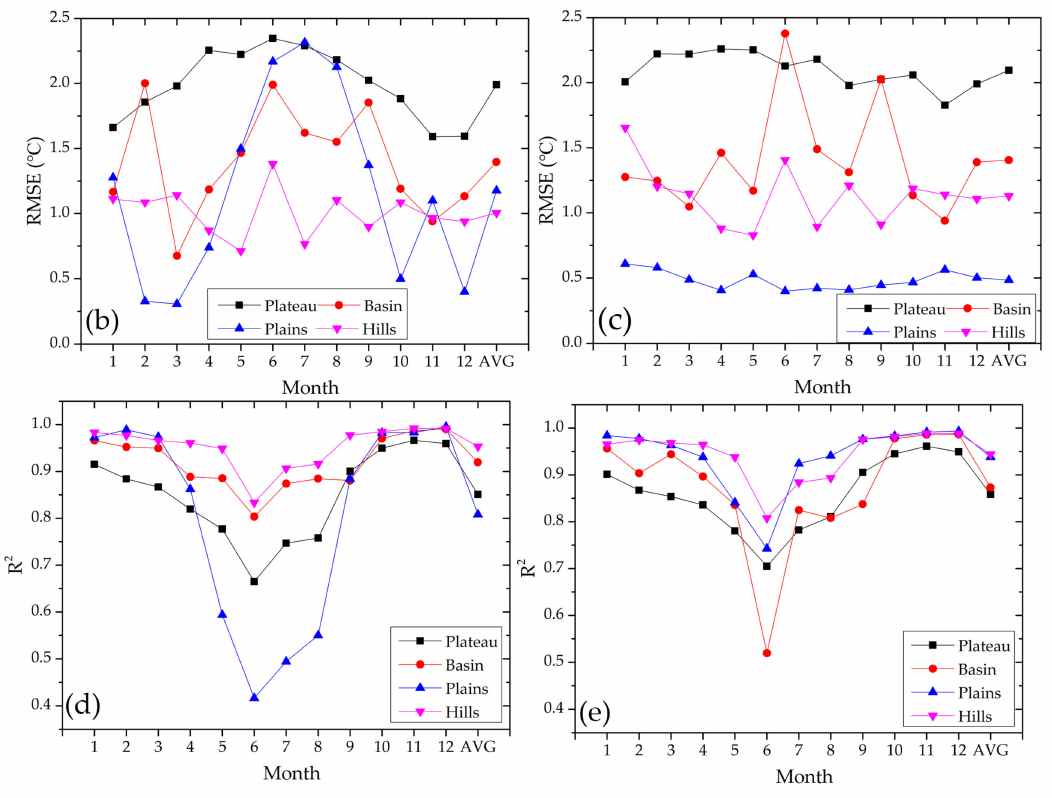
Figure 8. ( a ) The distribution of terrain in China; ( b , d ) RMSE and R 2 of the predicted monthly mean near surface air temperature (NSAT) using the Kriging model for varied terrain types in China in 12 months of 2010; ( c , e ) RMSE and R 2 of the predicted monthly mean NSAT using the geographically weighted regression model for varied terrain types in China in 12 months of